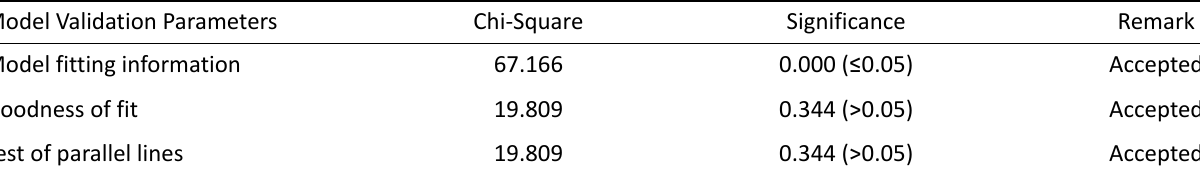
Table 7. Model validation parameters of ordinal regression model estimation.